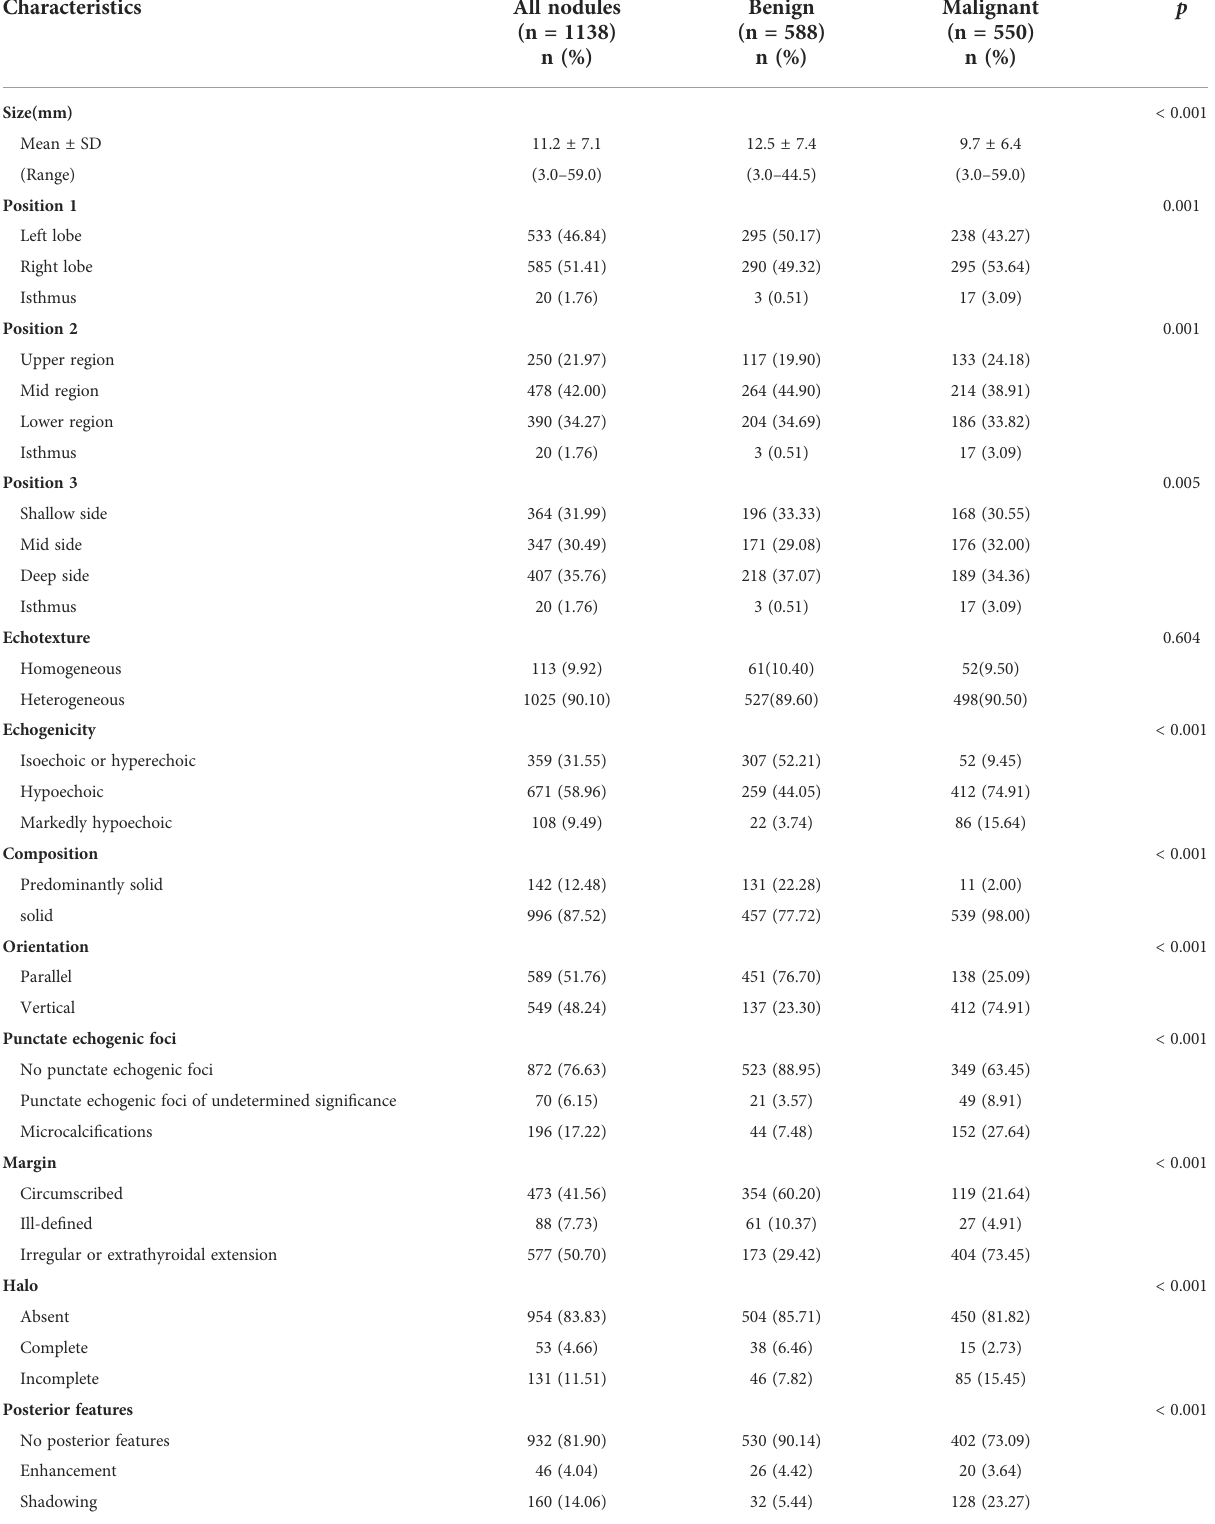
TABLE 1 Comparing the characteristics of benign and malignant thyroid